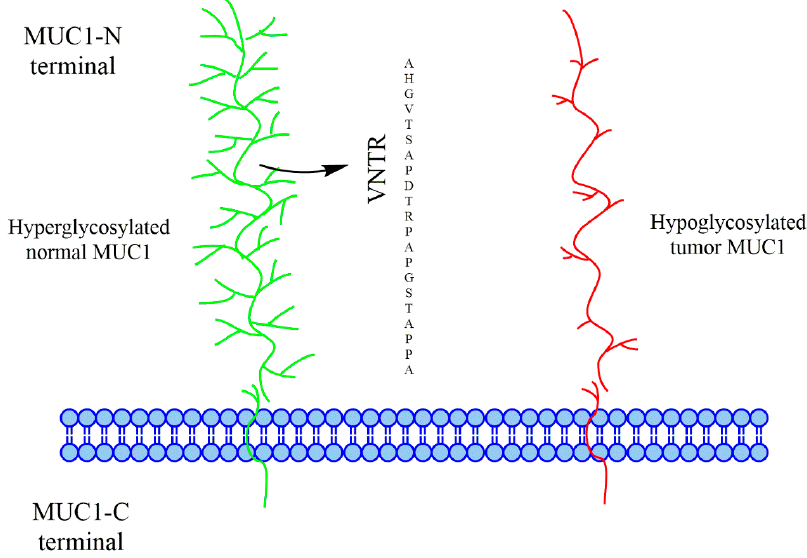
Figure 1. Difference between normal mucin 1 (MUC1) and tumor-associated MUC1.